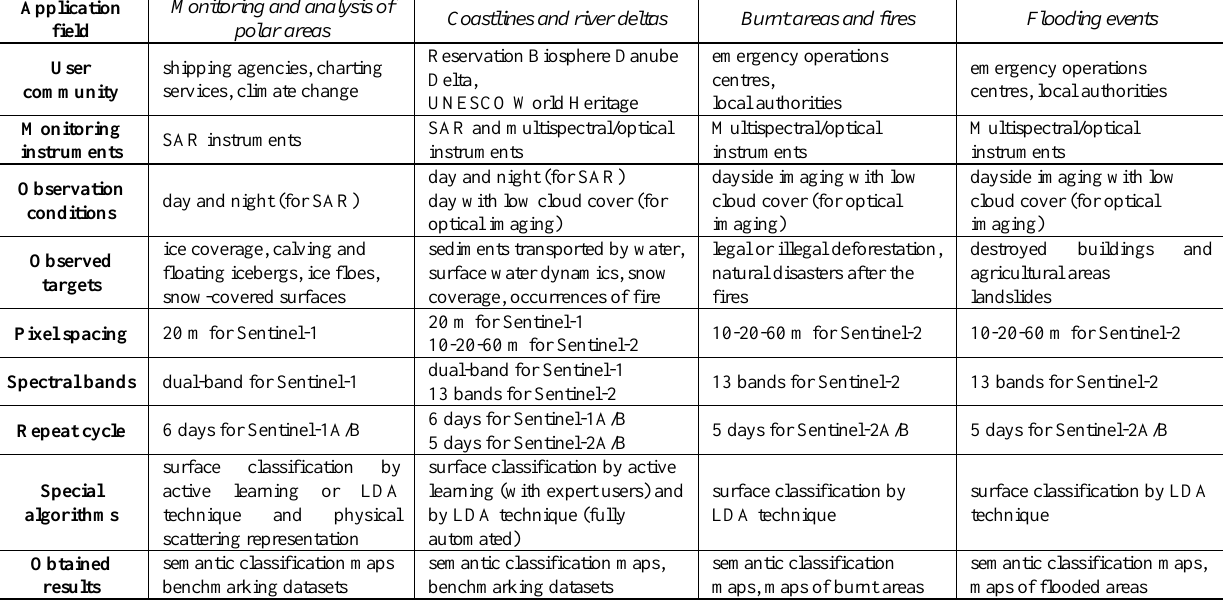
Table 1: Important requirements and parameters of our application using Sentinel-1/Sentinel-2